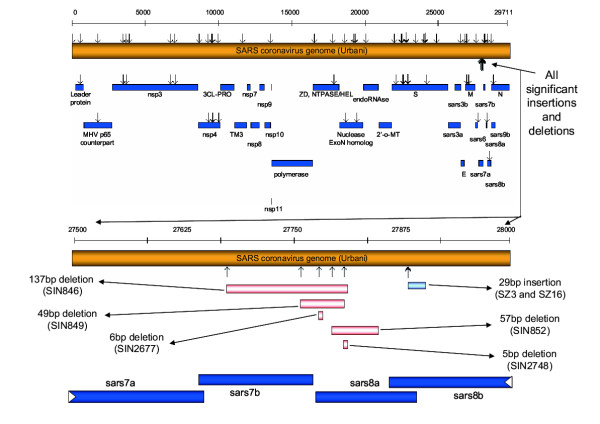
Map of significant mutations, insertions and deletions in the SARS-CoV genome. Map of the SARS genome, plotted with substitutions appearing in more than two isolates and other major insertion and deletion regions. Golden bars signify the SARS-CoV genome, with the approximate nucleotide positions shown in the scale on top of it. Arrows drawn on top of the genome indicate nucleotide mutations (i.e. variations shared by more than two isolates) observed in the SARS-CoV genome. Amino acid changes in SARS-CoV's proteins are reflected as arrows on top of the protein bars (blue bars). Significant multiple-nucleotide deletions (pink bar) and insertions (light-blue bar) were also observed (denoted as arrows under the genome) and appear to cluster around position 27000nt to 28000nt.